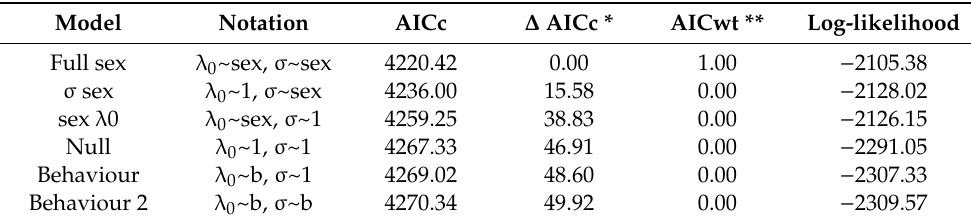
Table 1. Model summary table for spatially explicit capture-recaptured models (SECR) models used for estimating leopard